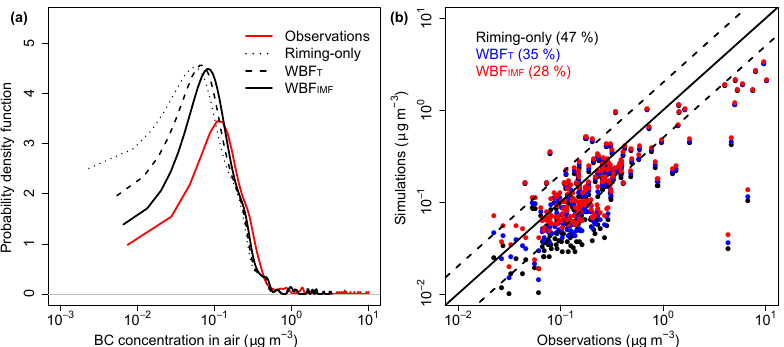
Figure 3. (a) Probability density function of observed (red line) and GEOS-Chem-simulated (dotted: riming; dashed: WBF T ; solid black: WBF IMF ) annual mean BC concentration in air (µgm − 3 ) and (b) observed and simulated annual BC concentrations (black: riming; blue: WBF T ; red: WBF IMF ; the percentage of annual BC concentrations locate outside the 1 : 2 and 2 : 1 lines are in parentheses; solid line – 1 : 1 ratio line, dashed lines – 1 : 2 (or 2 : 1) ratio lines). Data are for 2007–2009. See text for details.